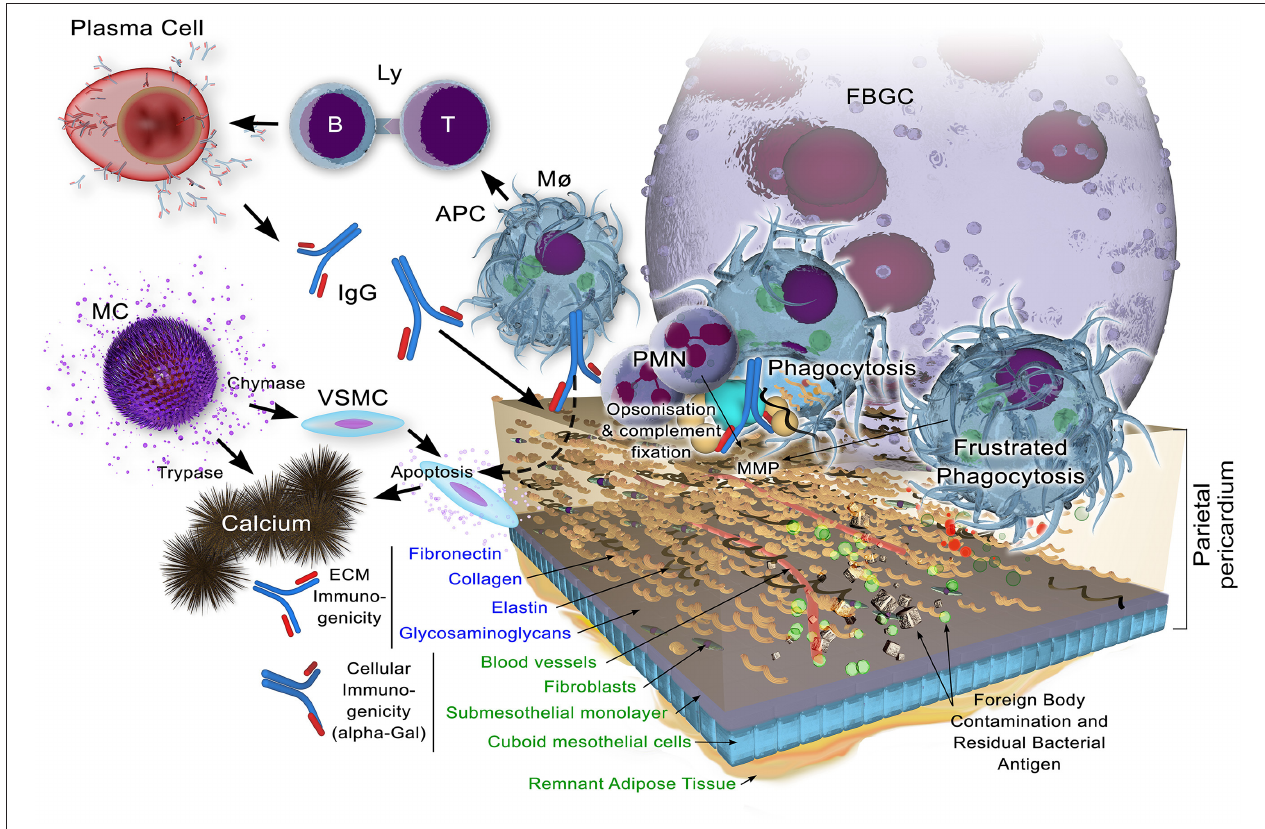
FIGURE 3 | Potential immune responses to xenogeneic pericardial tissue. While decellularization may remove the bulk of cellular components, including their highly immunogenic galactose- α 1,3 galactose ( α -Gal) antigen against which preformed natural antibody exists in the human recipient, remnant cellular antigens may yet persist. Structural extracellular components, apart from glycosaminoglycans which may be lost to some extent, are known immunogens which, when insufficiently masked through cross-linking, will bind immunoglobulin as a component of the adaptive immune response. Antigen is presented by antigen presenting cells (Macrophags, Mø, B-lymphocytes, B-Ly and dendritic cells) to T lymphocytes (Ly) with ensuing immunoglobulin production by plasma cells. This potentially opsonises the tissue for subsequent infiltration by Mø and polymorphonuclear neutrophils (PMNs). Matrix metalloproteinases (MMPs) contribute to the bioprosthesis